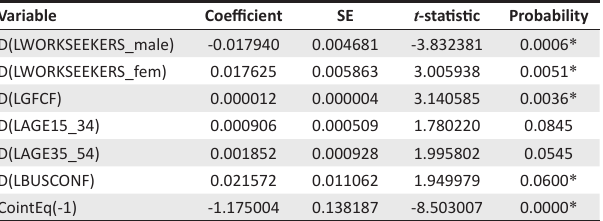
TABLE 6: Estimated error correction model (ECM)